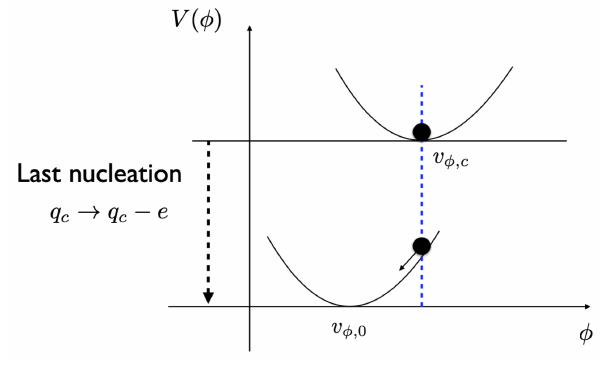
Figure 2 . The scalar potential for the pseudo-scalar field with the flux-dependent